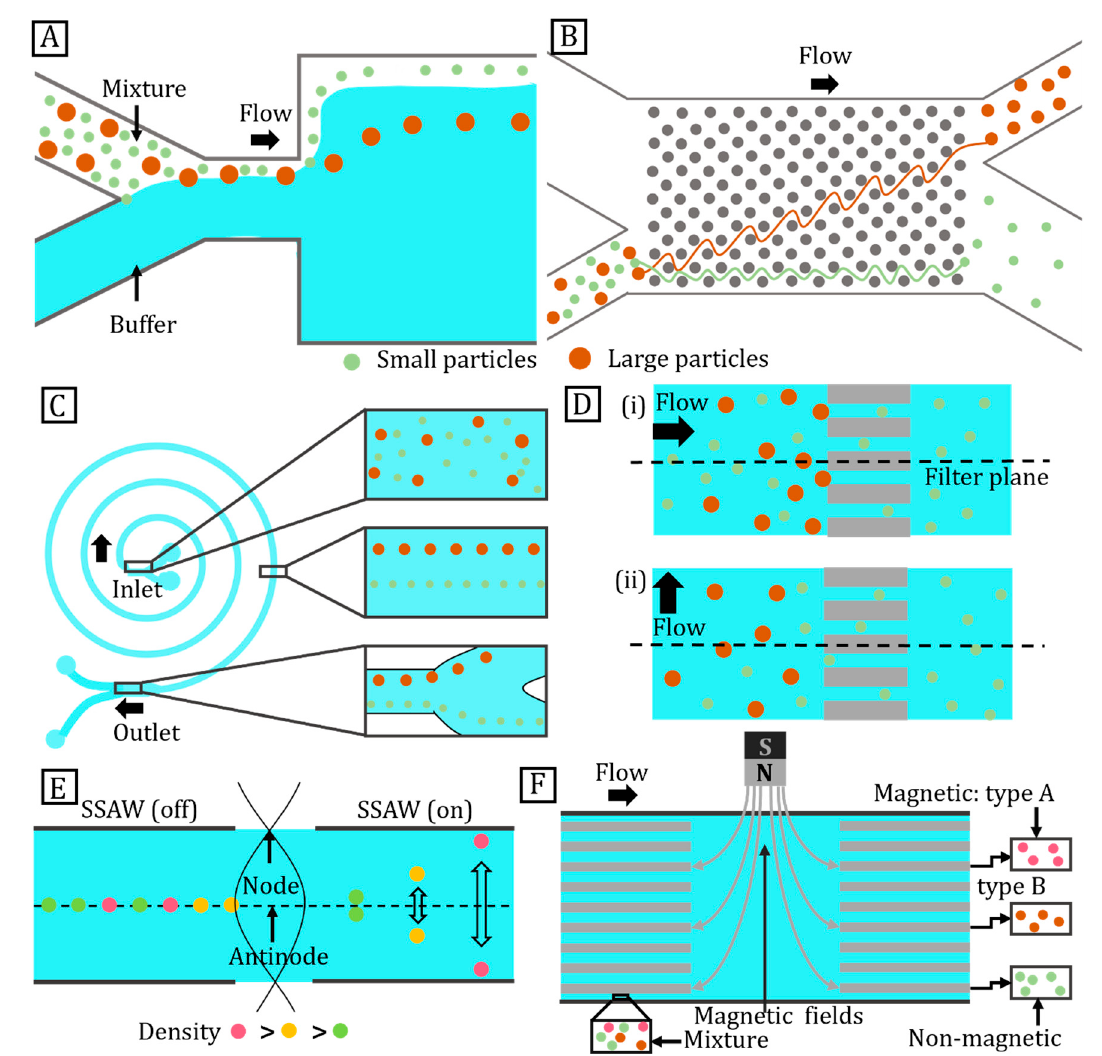
Figure 6. Particle sorting methods. ( A ) Microparticle sorting by pinched flow fractionation; ( B ) Mi- croparticle sorting by deterministic lateral displacement; ( C ) Particle sorting by inertial microfluidic separation; ( D ) Schematics illustrate microfilter arrangements for particle sorting: ( i ) Dead-end filter, ( ii ) Crossflow filter; ( E ) Density-based sorting of particles in acoustic field; ( F ) Magnetic particle separation based on their magnetic